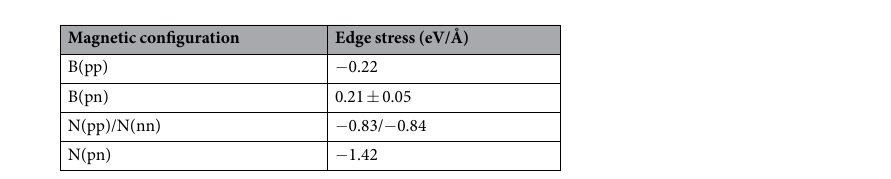
Table 2. The averaged edge stresses ( τ ) of individual edges of